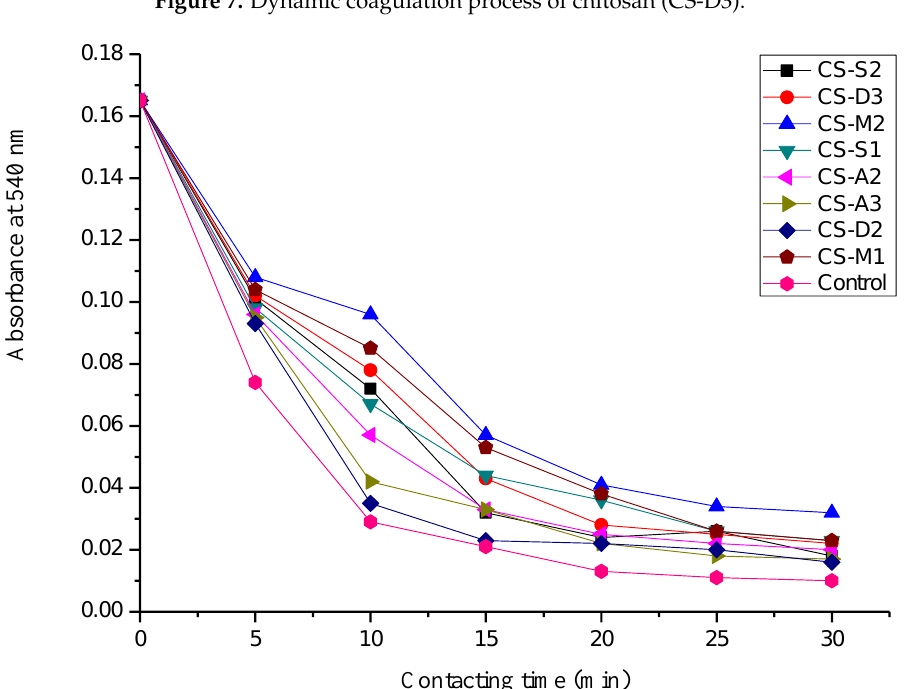
Figure 8. The dynamic coagulation curves of chitosan with various molecular parameters.